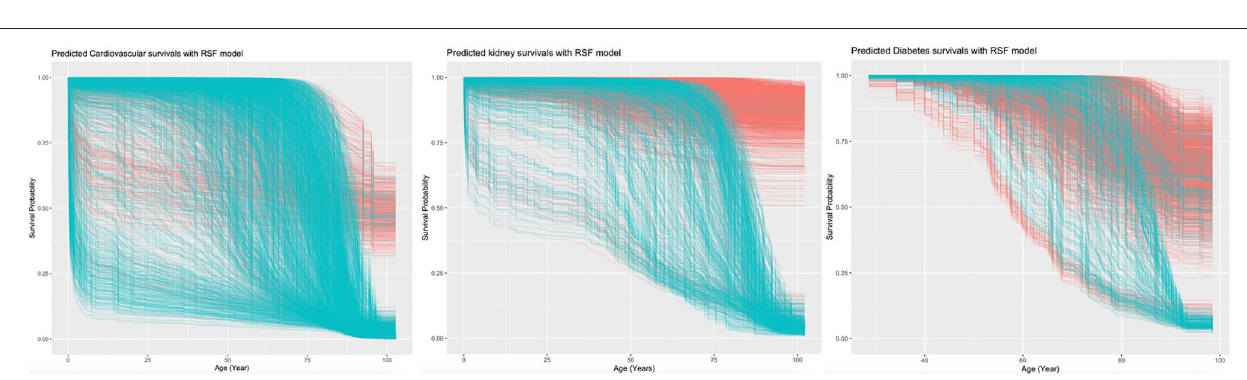
FIGURE 3 | Predicted survivals of cardiovascular, kidney, and diabetes complications with RSF model.